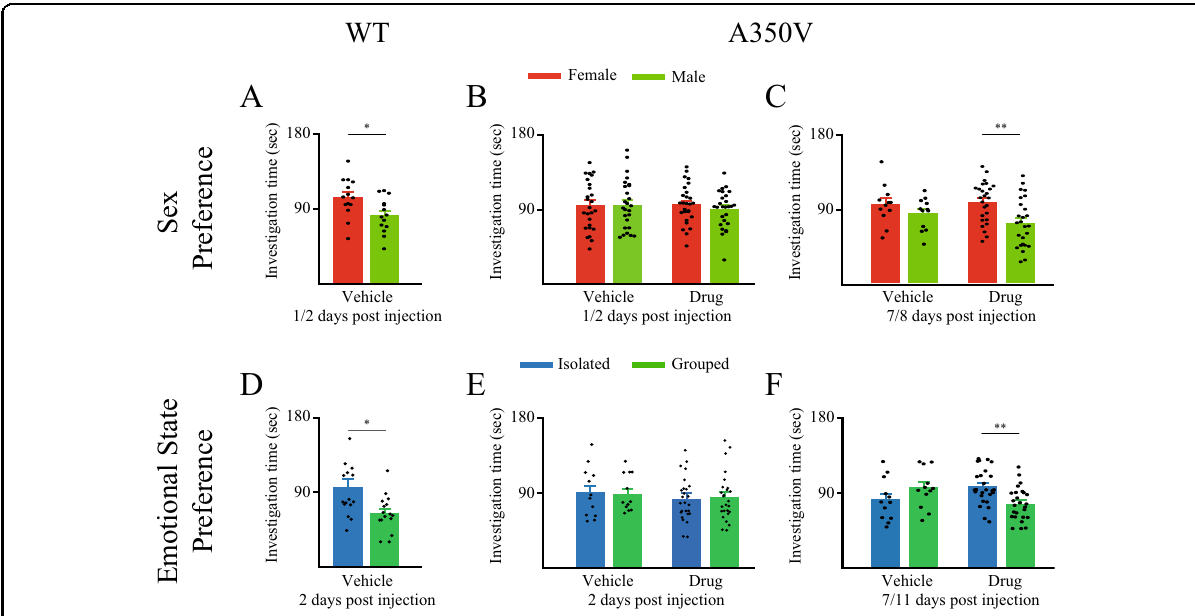
Fig. 4 PF-4778574 rescues sex social behavioral de fi cits in A350V Iqsec2 mice. A Mean investigation time summed separately for the Female and Male stimuli throughout the SxP test, conducted by WT mice 2 days after vehicle injection. B Mean investigation time summed separately for the Female and Male stimuli throughout the SxP test conducted by A350V mice 1 – 2 days after either vehicle (left, n = 26) or PF-4778574 (right, n = 26) injection. C As in B , for the SxP test conducted by A350V mice 7 – 8 days after either vehicle (left, n = 12) or PF-4778574 (right, n = 26) injection. D Mean investigation time summed separately for the Isolated and Grouped stimuli in the ESP test conducted by WT mice 2 days after vehicle injection. E Mean investigation time summed separately for the Isolated and Grouped stimuli in the ESP test conducted by A350V mice 1 – 2 days after either vehicle (left, n = 12) or PF-4778574 (right, n = 26) injection. F As in E , for the ESP test conducted by A350V mice 7 – 11 days after either vehicle (left, n = 12) or PF- 4778574 (right, n = 26) injection. * p < 0.05, ** p <0.01, paired t -test following the main effect in ANOVA test. All error bars represent